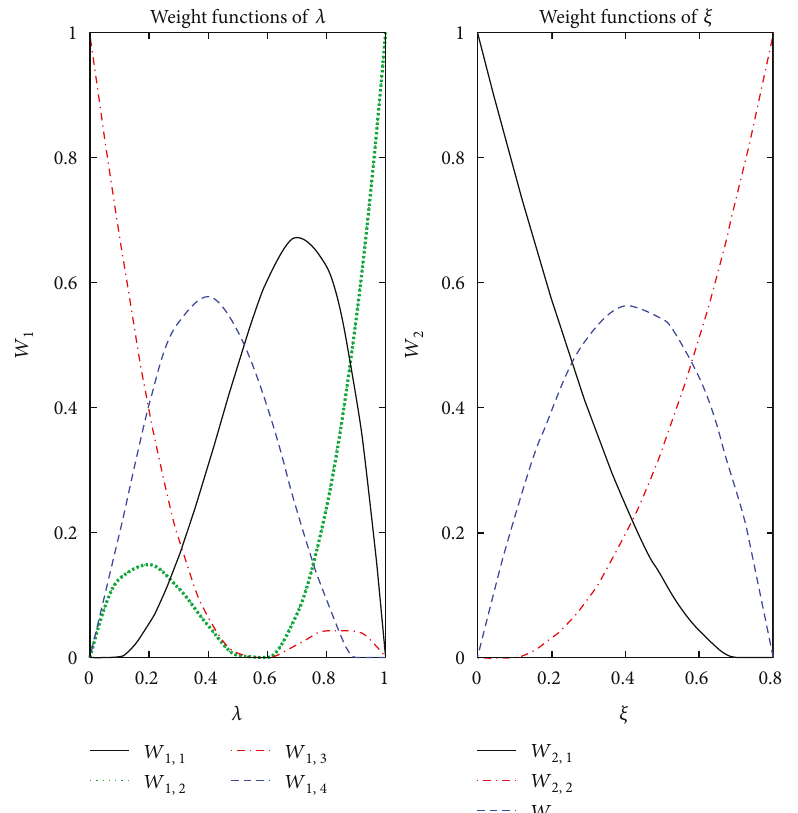
Figure 10: Weight functions of the convex